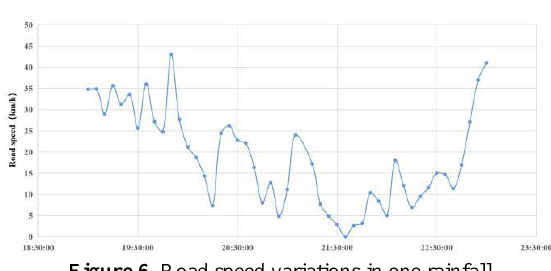
Figure 6 . Road speed variations in one rainfall Figure 7 is the Mann-Kendall trend test graph. It shows a decreasing trend after 19:30, and the road speed change abruptly. The intersection of the two lines coincides with the speed change in Figure 6, indicating that Mann-Kendall can detect the trend of the road change.